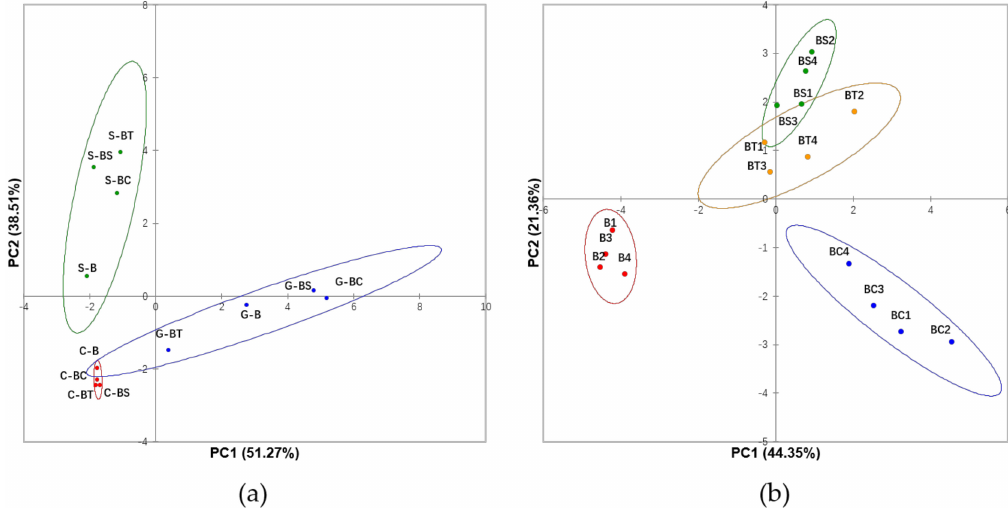
Figure 2. Bioaccessibility of polyphenols and antioxidant measures during digestion of black carrots are explained by the inclusion of lipids. Principal component analysis (PCA) of the dataset of individual polyphenols and phytochemical bioactivities (DPPH, FRAP, and TPC) dataset. Panel ( a ) shows the separation of gastric, small intestinal, and colonic digestive fluids. Panel ( b ) shows the separation of di ff erent carrot and oil combinations. Di ff erent groups are denoted by colours as shown in the legend. Abbreviations: G (gastric fraction), S (small intestinal fraction), and C (colonic fraction); B (black carrot only), BS (black carrot and sunflower oil mixture), BT (black carrot and tallow mixture), and BC (black carrot and coconut oil